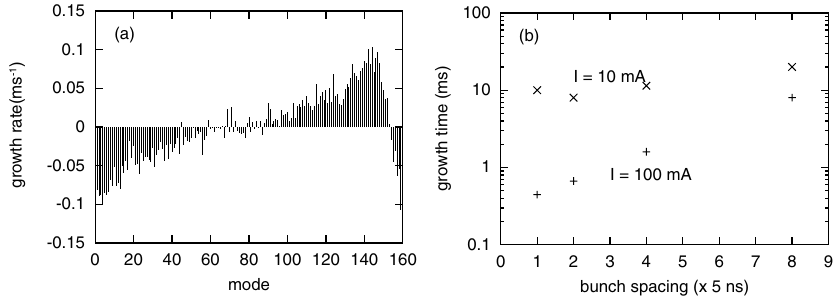
FIG. 5. Results of the wake force method for the BEPC. (a) is the mode spectrum at I (cid:7) 10 mA , where the negative values mean damping. (b) is the growth time for various bunch spacings at I (cid:7) 10 and 100